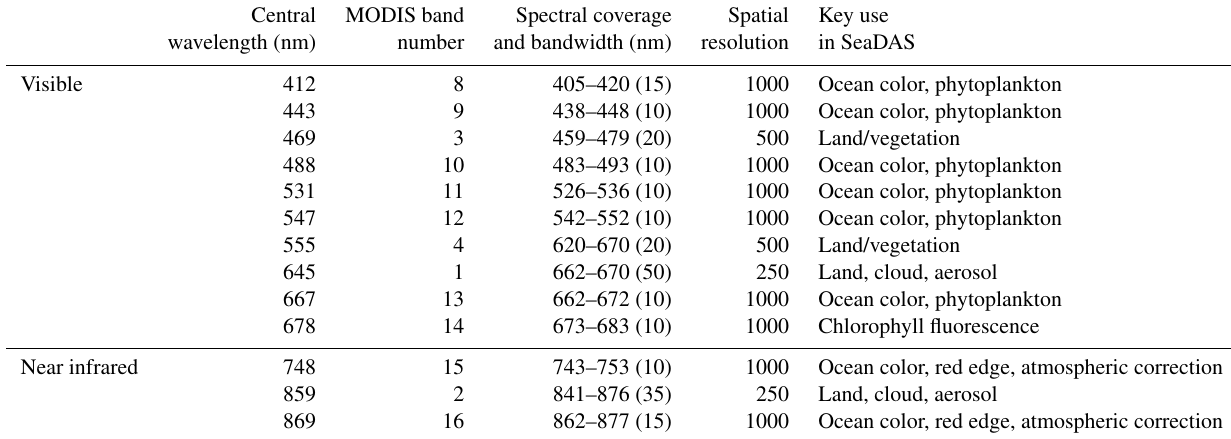
Table 1. Specification of the first 13 MODIS channels, including primary use, central wavelength, bandwidth, and spatial resolution; http: //eoweb.dlr.de:8080/short_guide/D-MODIS.html (last access: 13 August 2018). Central MODIS band Spectral coverage Spatial Key use